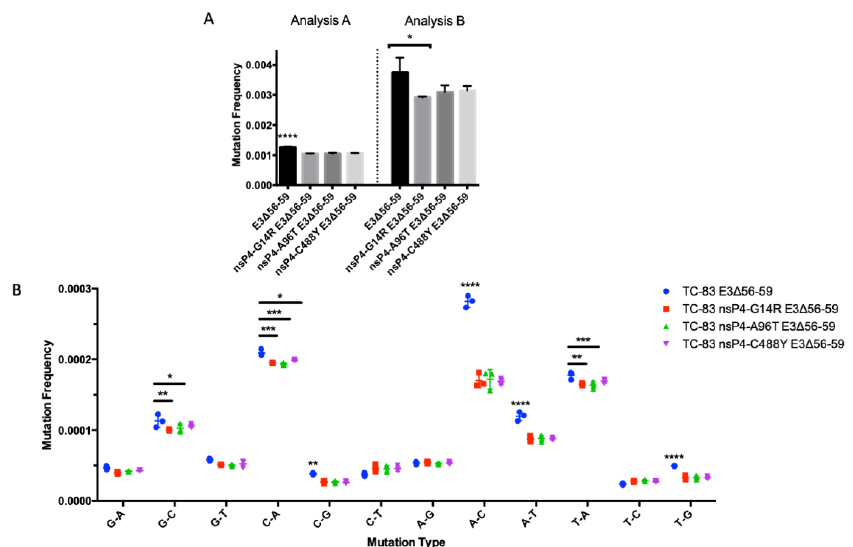
Figure 3. Mutation frequency of VEEV TC-83 E3Δ56-59 mutants. Overall mutation frequency of VEEV TC-83 E3Δ56-59 and mutants with nsP4 mutations that alter fidelity using two methods for analysis ( A ). Frequency of specific mutation types of VEEV TC-83 E3Δ56-59 and mutants with nsP4 mutations that alter fidelity with Analysis A ( B ). Mutation frequency was compared with one-way ANOVA and Tukey’s multiple comparisons test. p < 0.05 is represented by *, p < 0.01 is represented by **, p < 0.001 is represented by *** and p < 0.0001 is represented by ****.